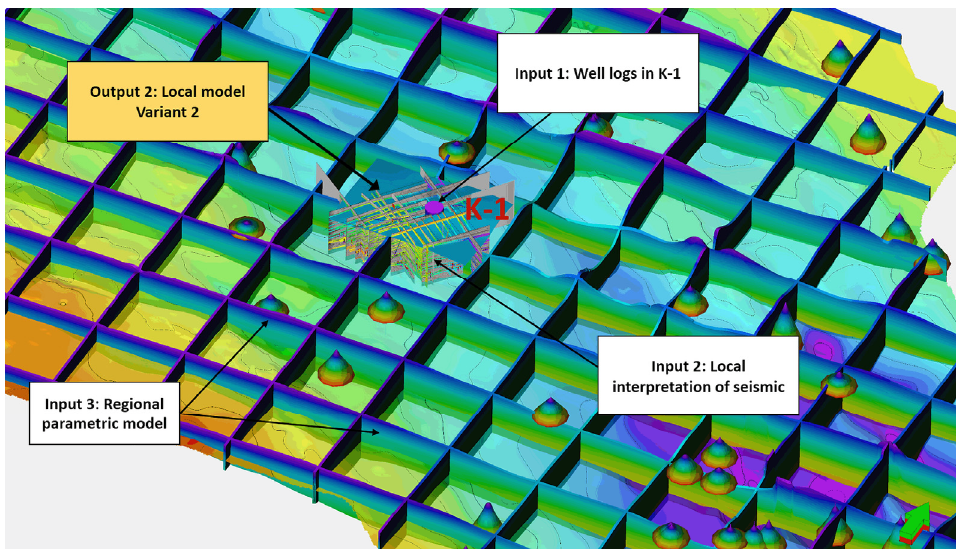
Figure 7. The structural and parametric model in variant SMV2.